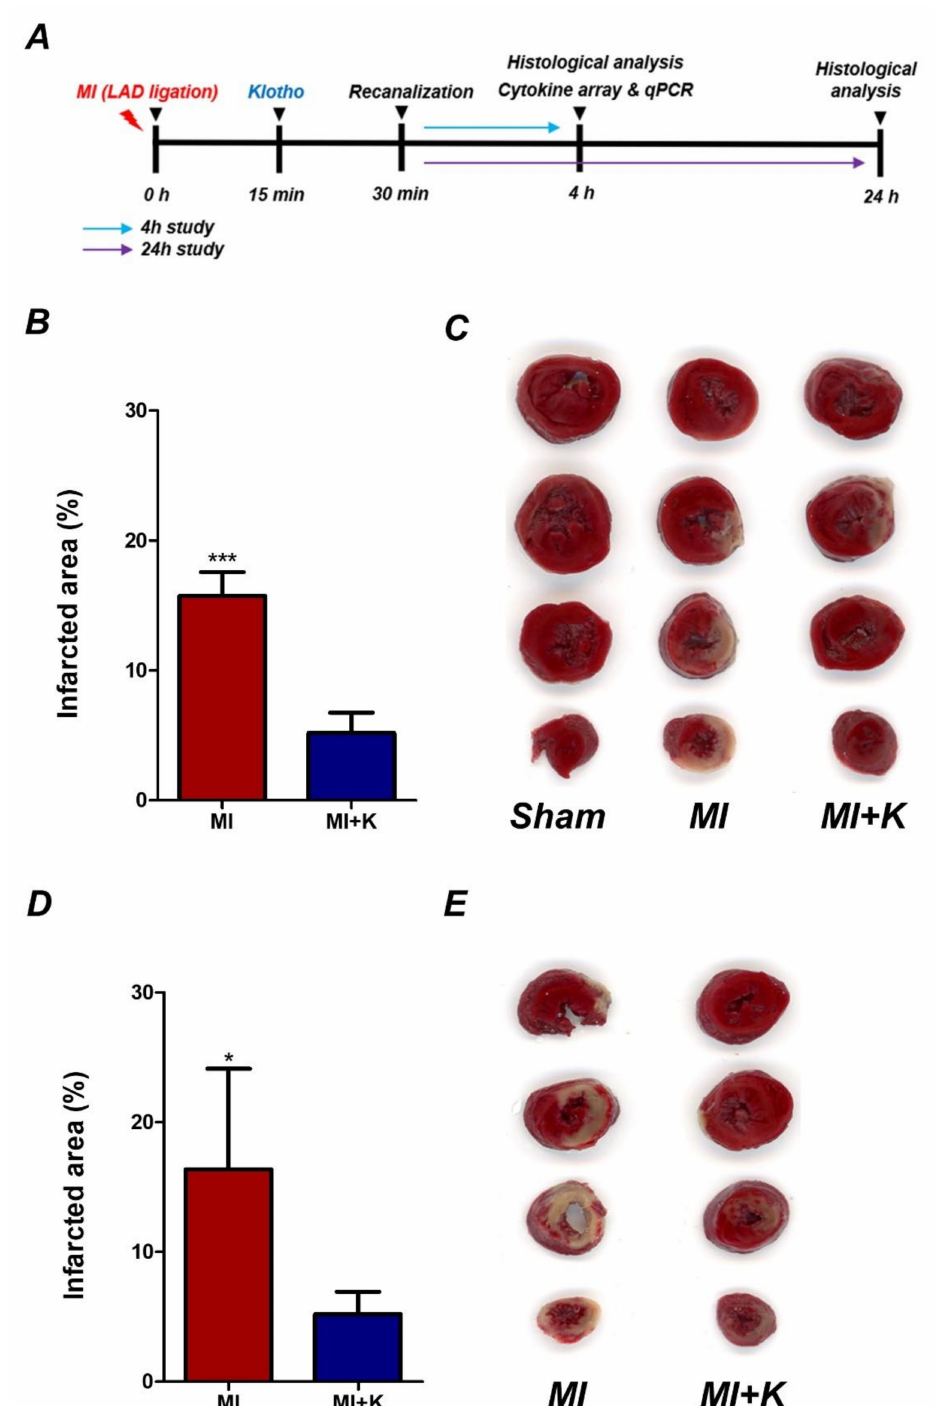
Figure 1. Recombinant klotho (rKL) reduces infarct volume after myocardial I/R injury. ( A ) Experi- mental schedule; ( B ) Volume of myocardial infarct area stained with of 2,3,5-triphenyltetrazolium chloride (TTC) at 4 h, *** p < 0.001, comparison of myocardial I/R with rKL, one-way analysis of variance (ANOVA) followed by Bonferroni post hoc test. ( C ) Representative image of 2,3,5- triphenyltetrazolium chloride (TTC) staining at 4 h; ( D ) Volume of myocardial infarct area stained with TTC observed at 24 h, * p < 0.05, comparison of myocardial I/R with rKL, unpaired t -test. ( E ) Representative image of 2,3,5-triphenyltetrazolium chloride (TTC) staining at 24 h (the number of animals: n = 5,